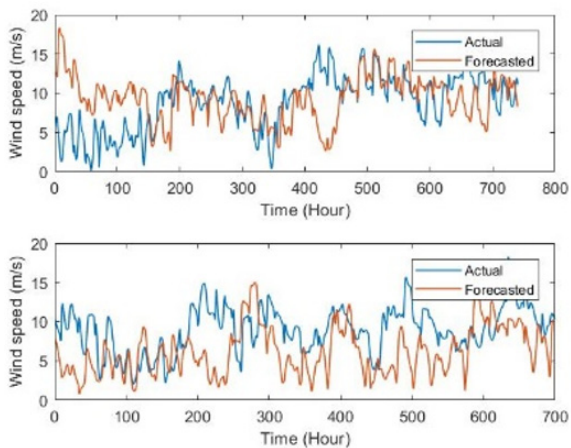
Figure 21. Forecasted and actual wind speeds of 2017, June & July, Khafji, Case